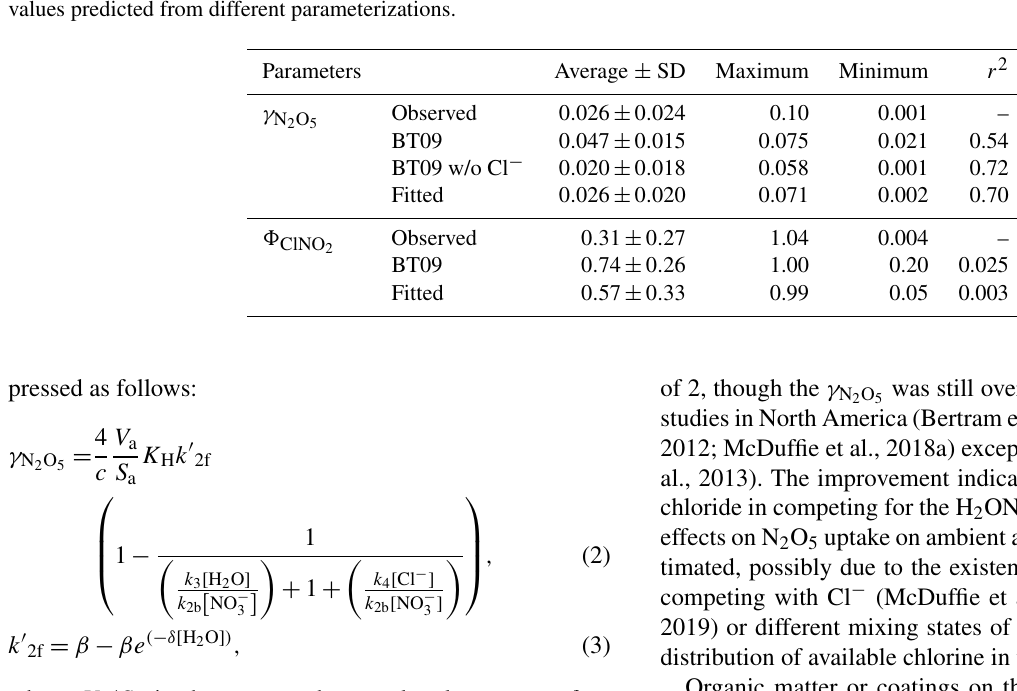
) with ; ClNO 2 yield, (cid:56) ClNO 2 2 O 5